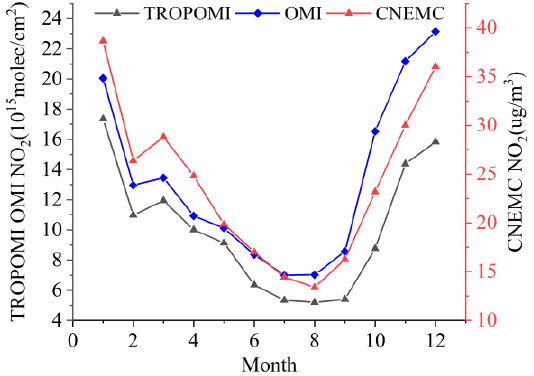
Figure 7. Comparison of the monthly averaged NO 2 mass concentration at CNEMC compared with the TROPOMI and OMI Trop NO 2 VCD in 2019.